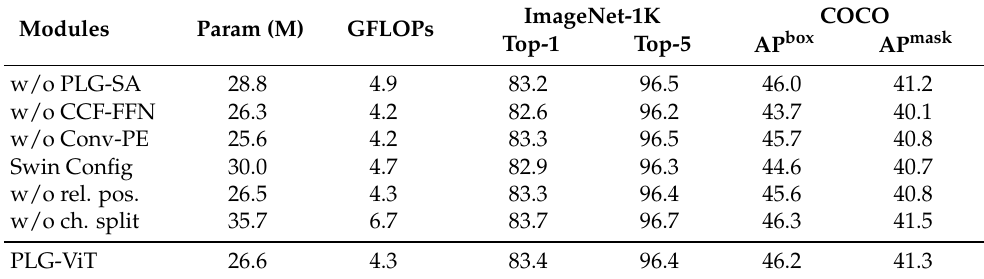
Table 5. Ablation study on the effectiveness of the components in PLG-ViT on the tasks of classifica- tion, detection, and instance segmentation. Mask RCNN [56] with a 1 was used for evaluation on COCO [22]. w/o PLG-SA: only local window self-attention; w/o